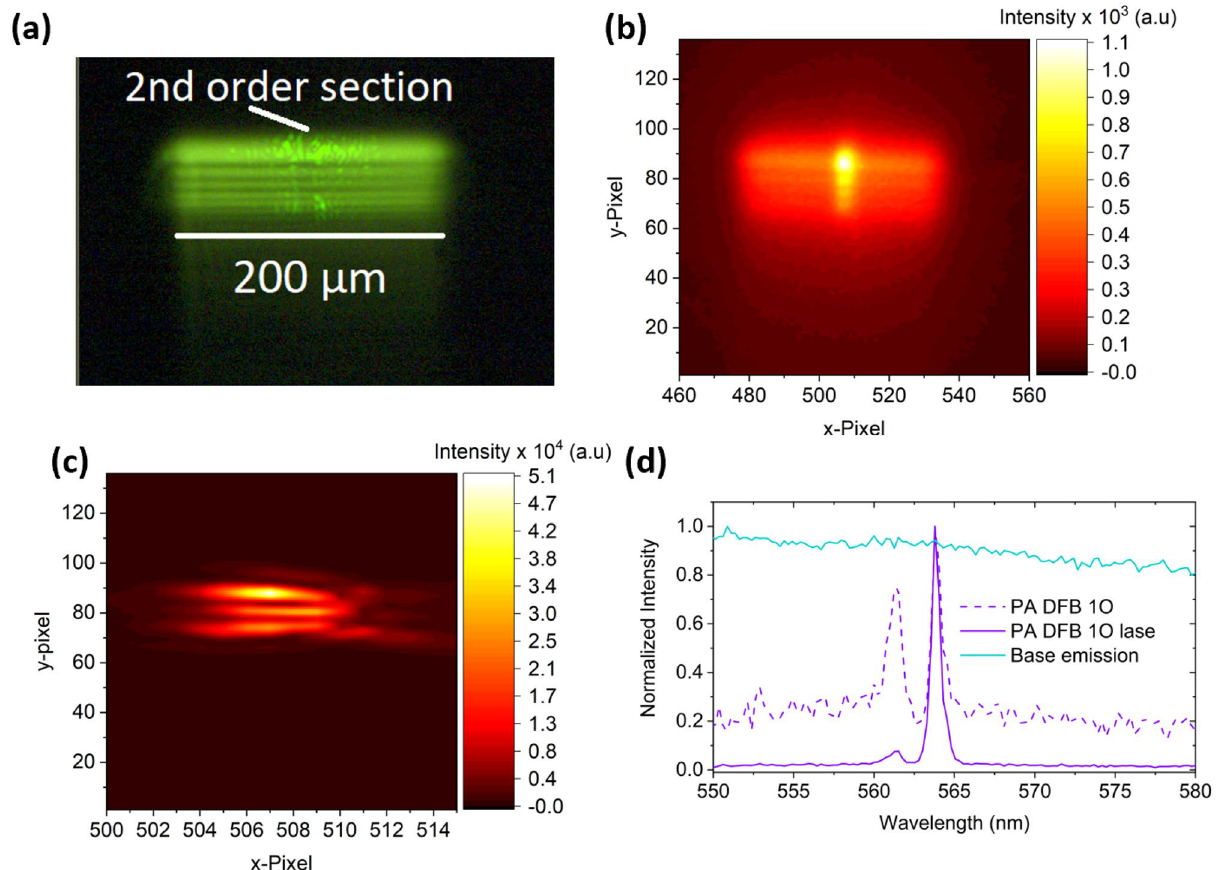
Figure 2. ( a ) zoom lens image of PA 1O DFB operated above threshold. Magnified (~ 4 ×) spatial “nearfield” captured by fully open entrance slit spectrograph in 0th order diffraction (reflection mode) of 60% γ PA 1O DFB ( b ) below and ( c ) above threshold. ( d ) Normalized spectra for 60% γ PA 1O DFB laser below lasing threshold (dotted violet) and above lasing threshold (filled violet), along with base emission in the absence of a